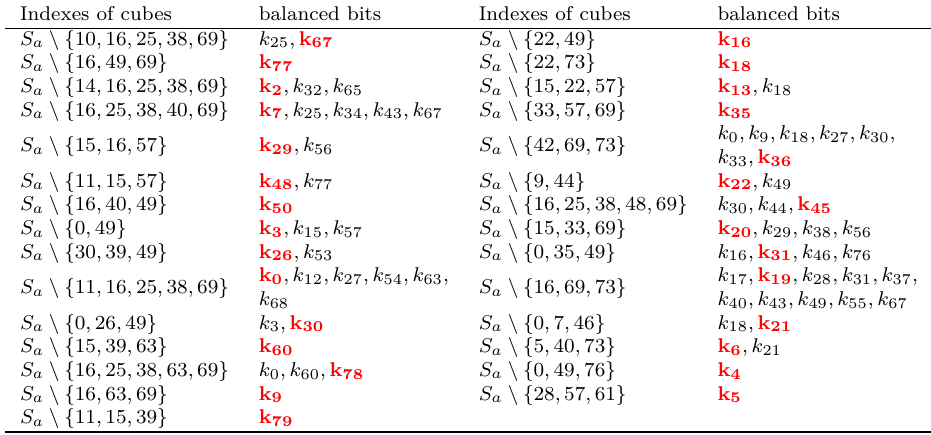
Table 6: Valuable cubes for attacking 806-round Trivium . Sorted by the deducing order. Indexes of